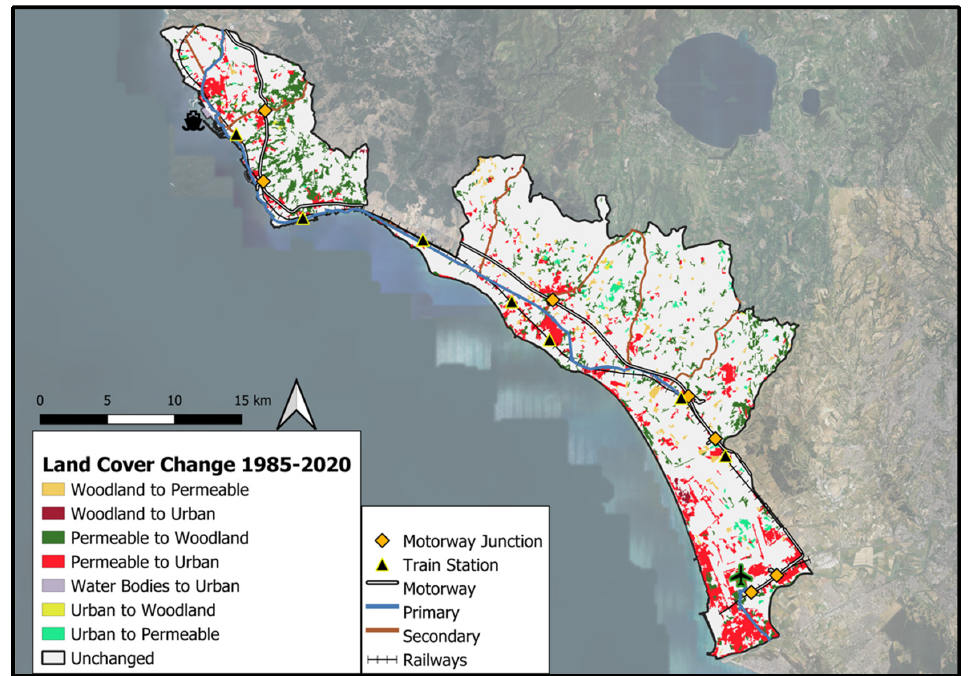
Figure 8. Variation and dynamics of LC within the study area for the total time span (1985 ÷ 2020), sieved image at a threshold of 5 pixels, 4-bit connectivity.